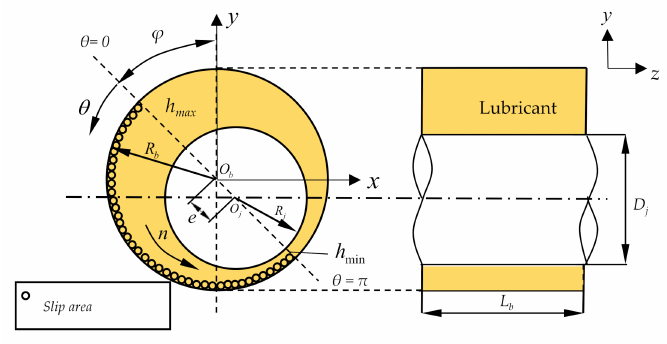
Figure 1. The slip/no-slip configuration, as shown in Figure 2, is applied on the stationary surface representing the bearing sleeve. In the present work, the slip/no-slip configuration bearing with a rectangular shape is of particular interest, based on the work of Fortier and Salant [8], Zhang et al. [12], and Cui et al. [17]. The slip is partially employed on the convergent area for extra generation of the load support [12,20]. In terms of the slip zone, for all following computations, the slip area is arranged from the angular coordinates, namely the circumferential angle θ of 0 ◦ , with the reference position measured at the h max , to the θ of 180 ◦ , as indicated in Figure 1. It was proven that such a pattern (i.e., rectangular shape, and partial slip surface zone) gives a better tribological performance with higher hydrodynamic pressure in a narrower cavitation region. In the frame of both experimental and theoretical studies, it is believed that the flow characteristic during lubrication in the journal bearing can be altered by introducing the heterogeneous slip/no-slip pattern in a more positive way, concerning the improvement of the tribological performance. Table 1 describes the parameters of the simulation model, including the geometry, operational condition, and the corresponding lubricant properties.